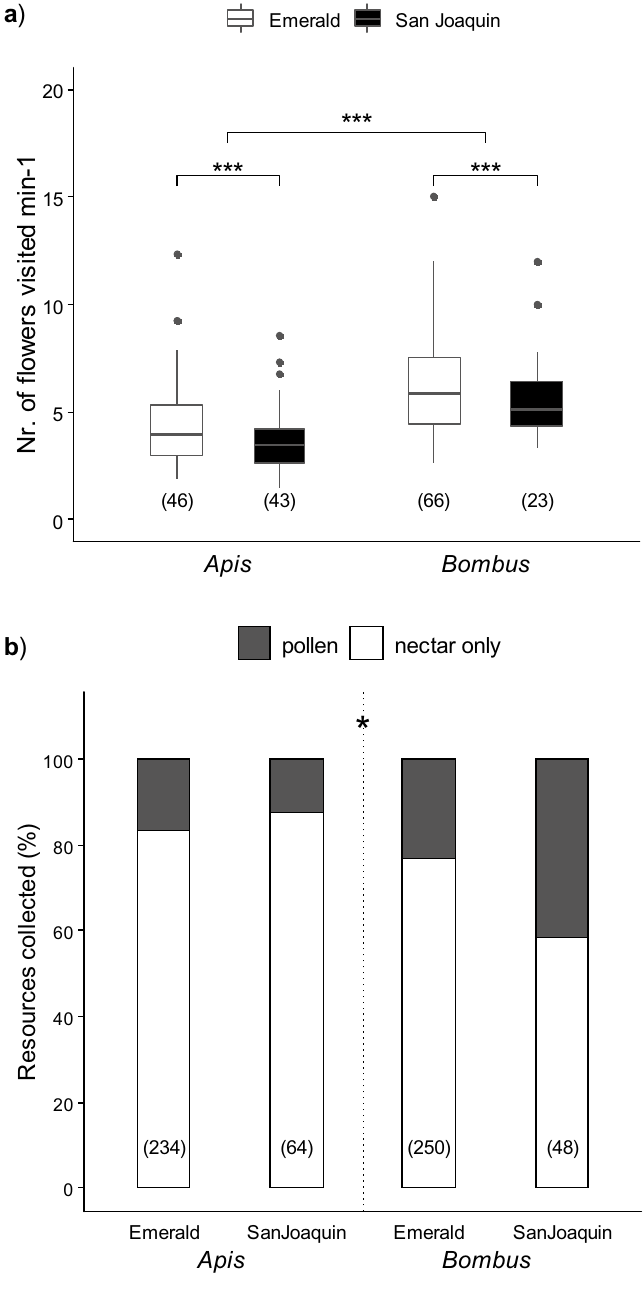
Figure 2. Foraging patterns of Apis mellifera and Bombus pauloensis on ‘Emerald’ and ‘San Joaquin’ cultivars. (a ) Number of flowers visited per minute by both species. Bumblebees visited more flowers than honeybees and ‘Emerald’ flowers were more frequently visited by both species. Boxplot shows the median and interquartile range (IQR), with whiskers showing the maximum value within 1.5 IQR, and individual points mark values outside this range. ( b ) Resources foraged by both species (EM: Emerald; SJ: San Joaquin). Bumblebees foraged for pollen in a greater proportion on both cultivars. Asterisks indicate statistical differences (***, p < 0.001). Sample size indicated in